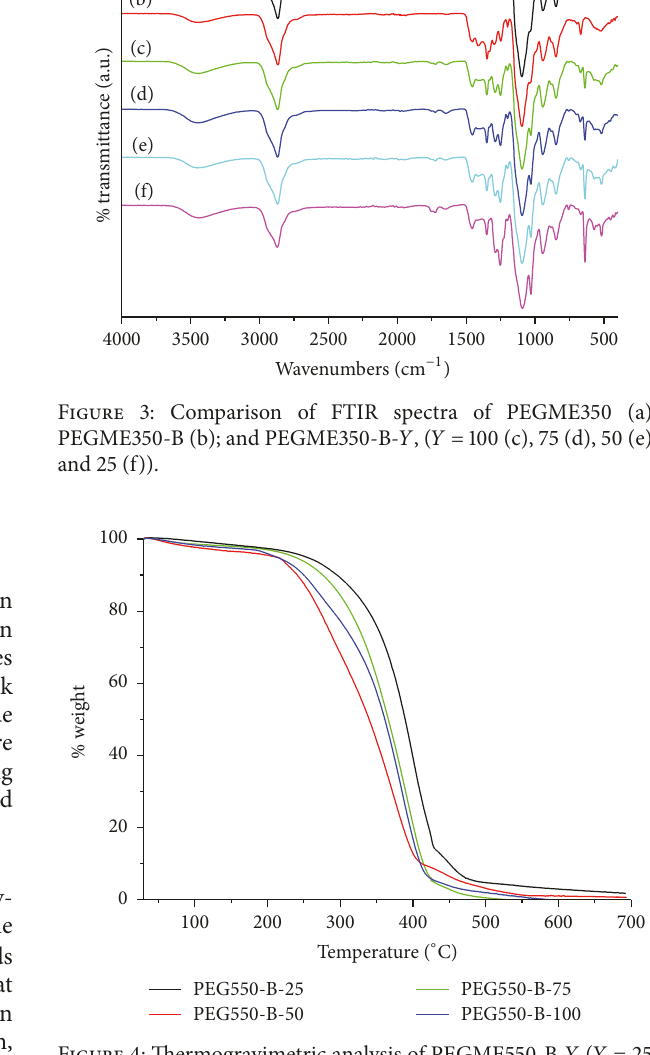
Figure 4: Thermogravimetric analysis of PEGME550-B- 𝑌 ( 𝑌 = 25, 50, 75, and 100) polymer electrolytes under nitrogen atmosphere at a heating rate of 10 ∘ C ⋅ min −1